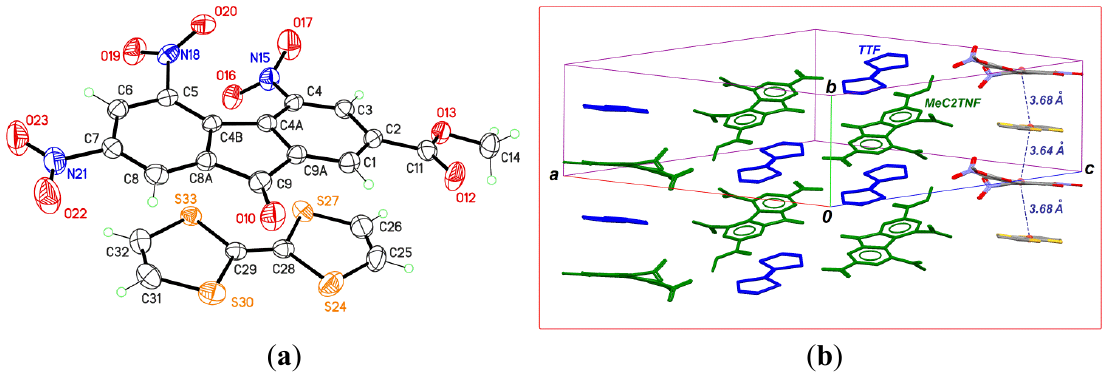
Figure 2. ( a ) ORTEP -like view of the asymmetric unit in 2 , with 30% displacement ellipsoids for non-H atoms; ( b ) Part of the packing structure of 2 , showing separations between TTF and MeC2TNF in one stack. All H atoms have been